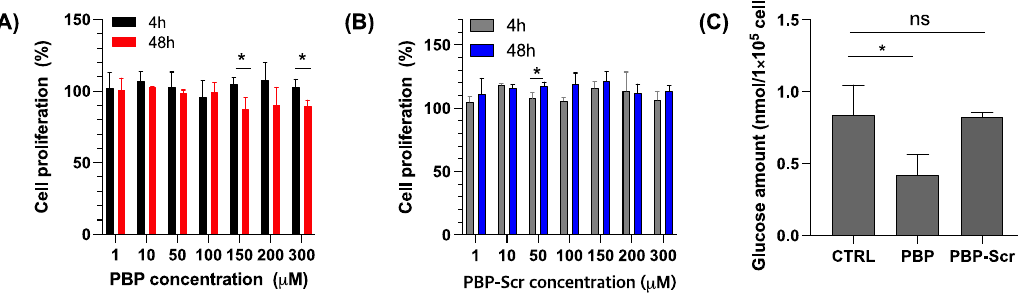
Figure 1. Effects of PBP or PBP-Scramble (PBP-Scr) priming on cancer cell viability and intracellular glucose. ( A , B ) B16F10 cancer cell viability after treatment with increasing concentrations of PBP or PBP-Scr for four hours or 48 h. Statistical analysis was performed using a t -test, p < 0.05. ( C ) Glucose amount in B16F10 cell lysates after PBP or PBP Scr (150 µ M) treatment for 48 h compared to untreated cells. Statistical analysis of the data was with two-way ANOVA, Tukey test (* p < 0.03, and ns = non-significance).